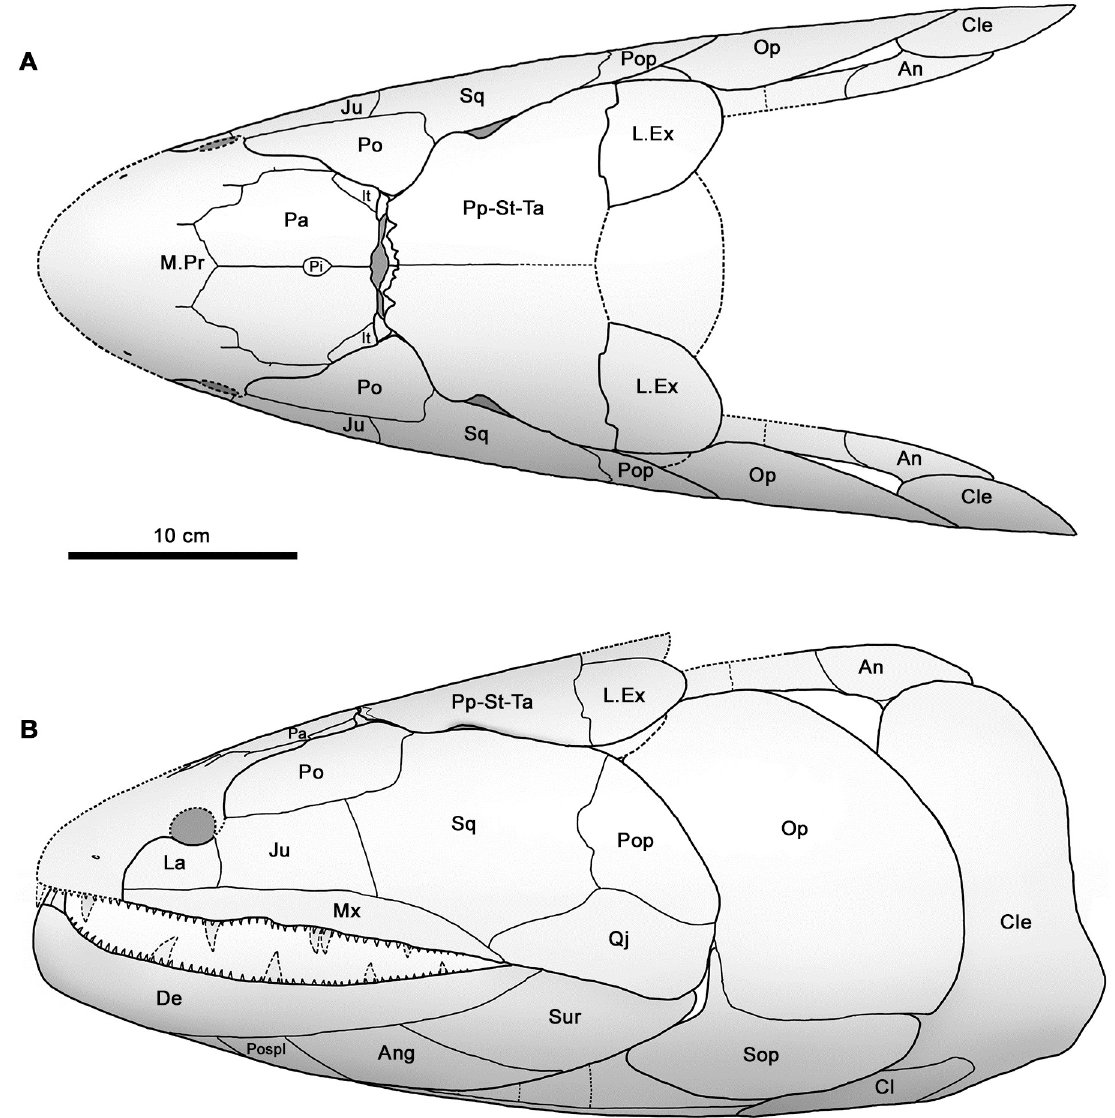
Fig 3. Skull reconstruction of Hyneria udlezinye . Dorsal (A) and lateral (B) views, drawn from photographs of a three-dimensional model, scaled to the size of the holotype. Abbreviations: An, anocleithrum; Ang, angular; Cl, clavicle; Cle, cleithrum; De, dentary; It, intertemporal; Ju, jugal; La, lacrimal; M.Pr, median postrostral; Mx, maxilla; Op, opercular; Pa, parietal; Pi, pineal; Po, postorbital; Pop, preopercular; Pospl, postsplenial; Pp-St-Ta, postparietal, supratemporal and tabular (sutures not visible); Qj, qudratojugal; Sop, subopercular; Sq, squamosal; Sur,